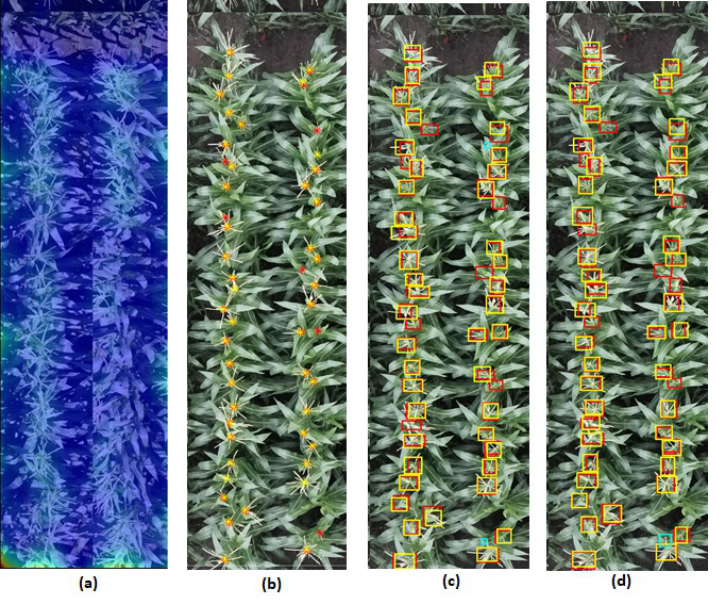
Figure 14. Results of Test Subset 5 (Ng: Red, TP: Yellow, FP: Cyan). ( a ) TasselNetv2+. ( b ) CenterNet. ( c ) TSD. ( d )